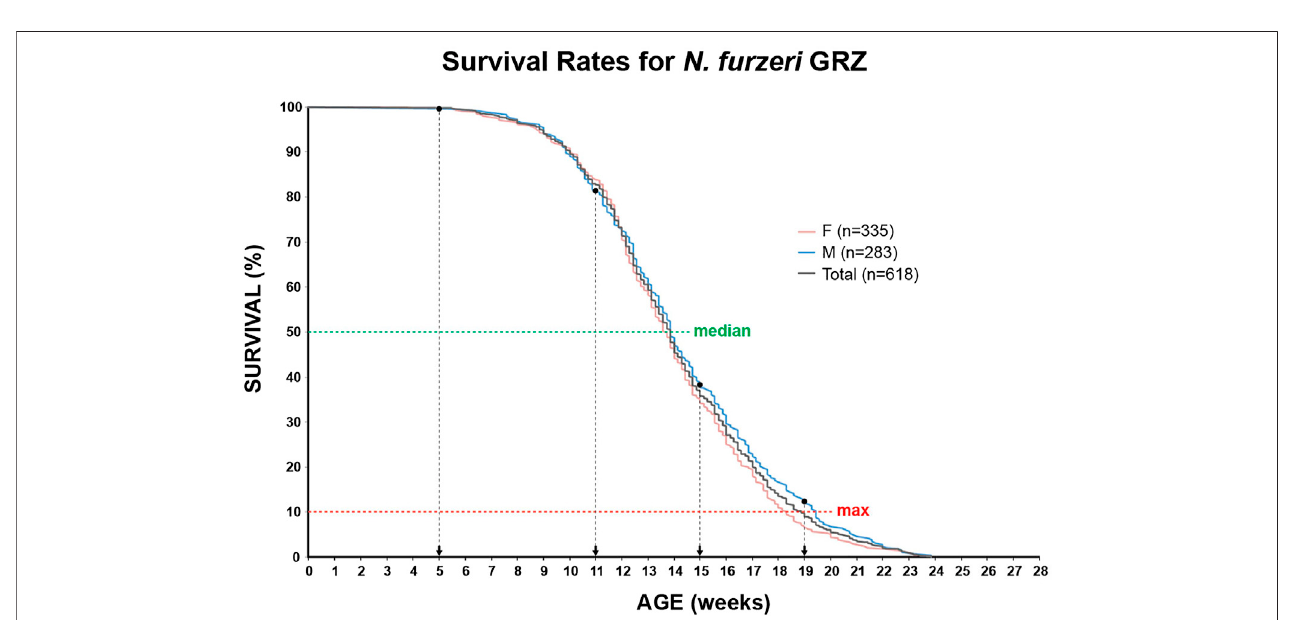
FIGURE 4 | Survivorship curve of the N. furzeri GRZ strain. Kaplan Meier estimates incorporating age-dependent mortality data of ten consecutive hatches for female ( n (cid:2) 335) and male ( n (cid:2) 283) populations. Total number of animals n (cid:2) 618. As fi sh reach their sexual maturity at 5 weeks, this age represents the experimental starting point. Median (50%) and maximum (90%) survival are illustrated as green and red horizontal, dashed lines, respectively. Selected time points for qRT-PCR analysis and global DNA methylation/hydroxymethylation quanti fi cation are indicated.